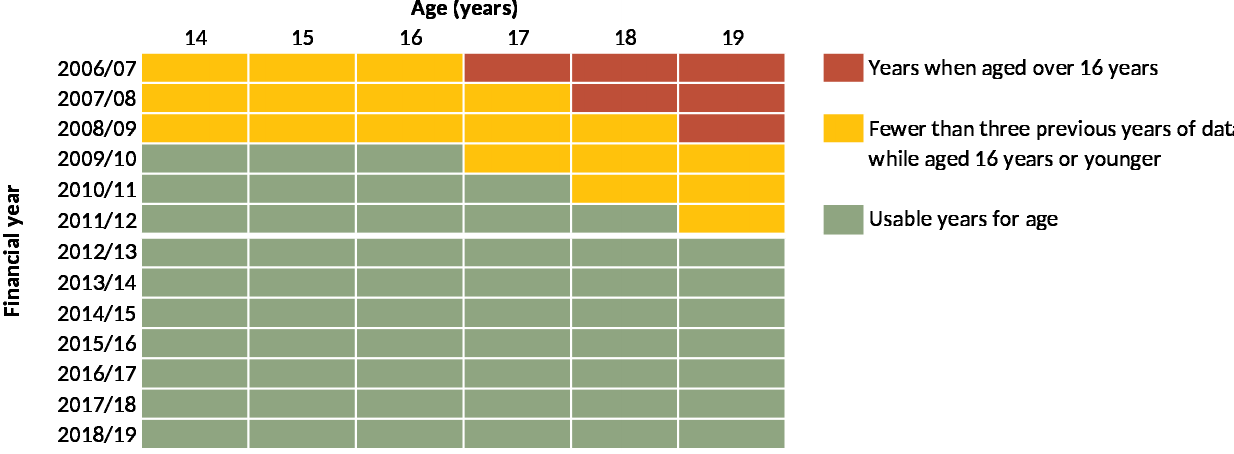
Figure 1. Years of data that could be used in the analysis. Years of available data showing the years in which, for each age in that year, there were data for at least three earlier years while a young person of that age was aged 16 years or